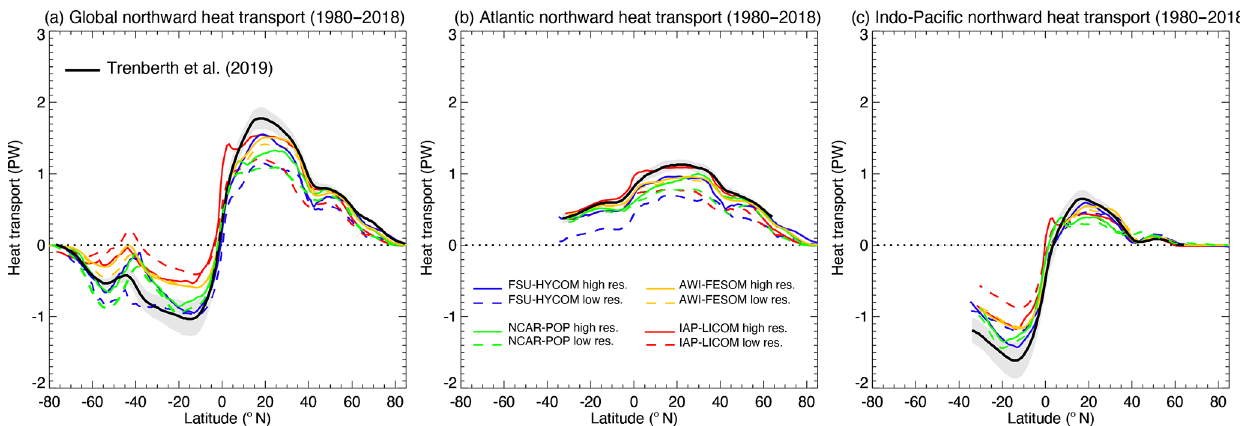
Figure 28. Modeled time mean meridional heat transport in PW over 1980–2018: (a) global, (b) Atlantic Ocean, and (c) Indo-Pacific Ocean. Black lines are the latest observational results from Trenberth et al. (2019) with